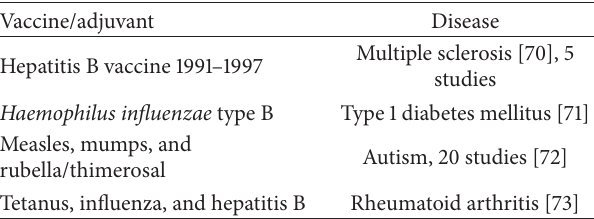
Table 3: Lack of associations between vaccination and autoimmune